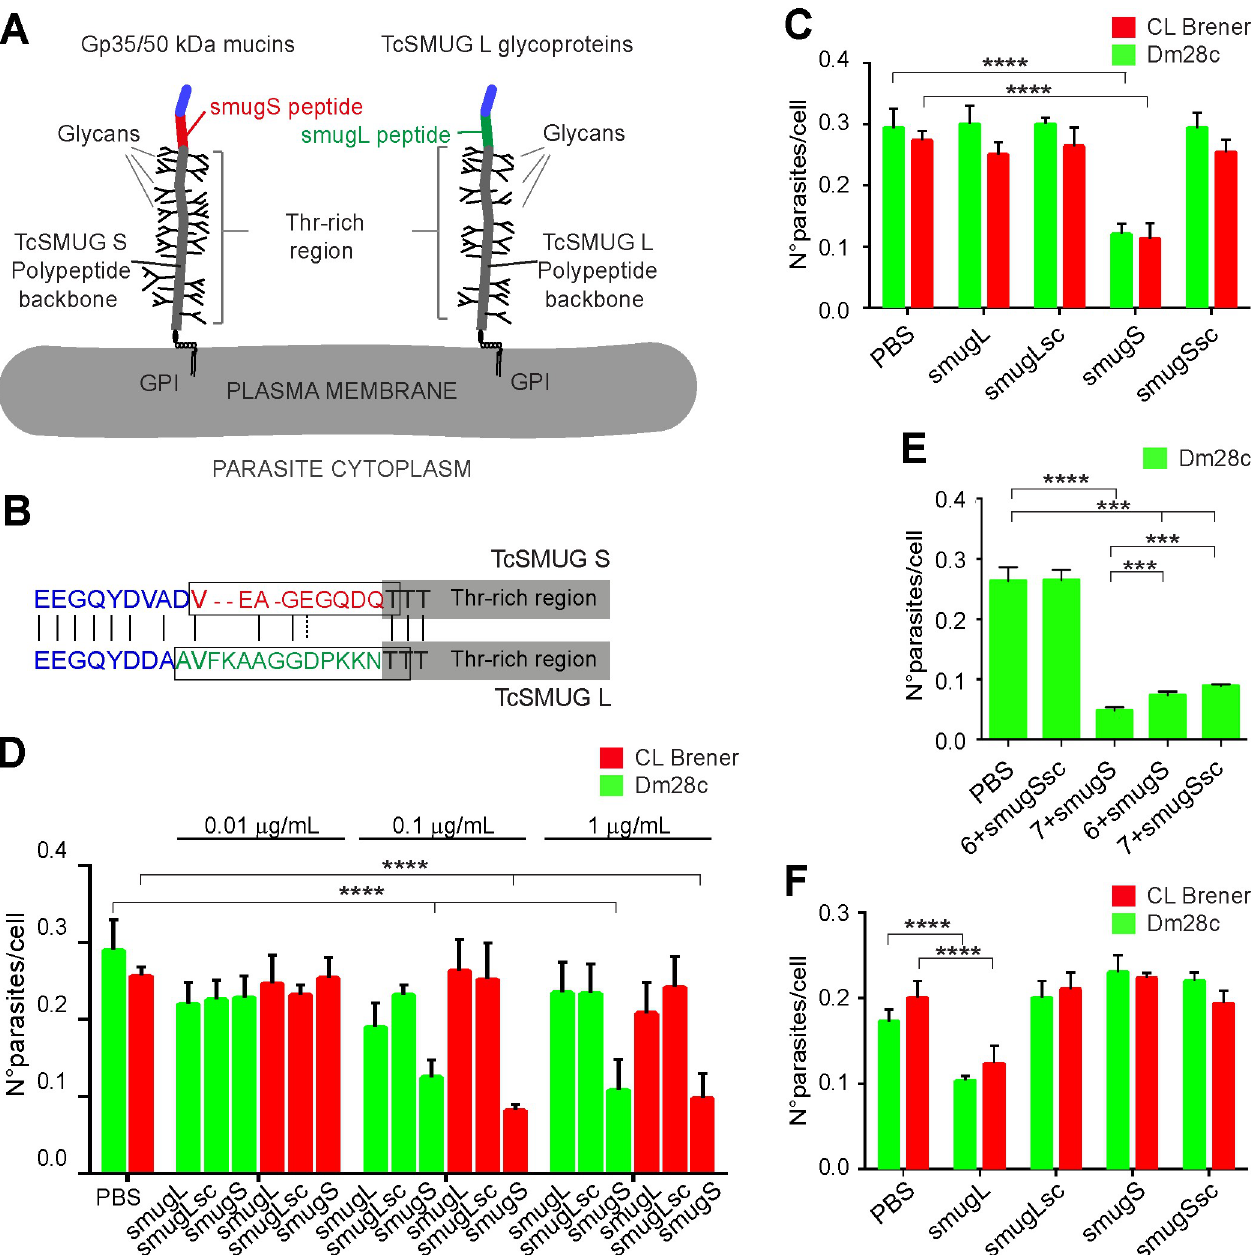
Fig 5. Peptidic determinants mediate adhesion of Gp35/50 kDa mucins to T . infestans rectal ampoule. A) Schematic diagram showing the structural features and topological disposition of surface-displayed Gp35/50 kDa mucins and TcSMUG L glycoproteins. The relative position of the smugS and smugL peptides on the overall polypeptide is indicated. GPI, glycosylphosphatidyl inositol. B) Sequence alignment between the mature N- terminal regions from TcSMUG S and TcSMUG L canonical proteins. Amino acids are colorized in accordance to their relative position on the polypeptide, as defined in A . Residues included in the smugS and smugL peptides are boxed. C-F) Freshly dissected rectal ampoules (C-E) or midgut tissues (F) obtained from fifth-instar nymphs 12–15 days after the last bloodmeal were incubated for 30 min in PBS or PBS supplemented with the indicated synthetic peptide (at variable concentrations in panel D ; at 0.1 μ g/mL in panels C and F and added with interaction medium containing 2 x 10 3 CL Brener or Dm28c epimastigotes. In panel E , tissues were incubated for 30 min in PBS or PBS supplemented with the indicated synthetic peptide (0.1 μ g/mL) and carbohydrate compound (as numbered in Fig 4A; 20 nM each). In all cases, adhered epimastigotes were counted per 100 epithelial cells in 10 different fields of each hindgut preparation. For each experimental group, 10 insects were used and experiments were performed in triplicate. Data are expressed as mean ± S.D. and asterisks denoted significant differences ( ��� when P < 0.001; and ���� when P < 0.0001) between each of the indicated populations and the control (PBS treated) population, as assessed by ANOVA and Tukey’s tests. In panel E , additional pairwise comparisons were carried out (compound 7 + smugS peptide vs compound 6 + smugS peptide and compound 7 + smugS peptide vs compound 7 + smugSsc peptide), and results are indicated as above.